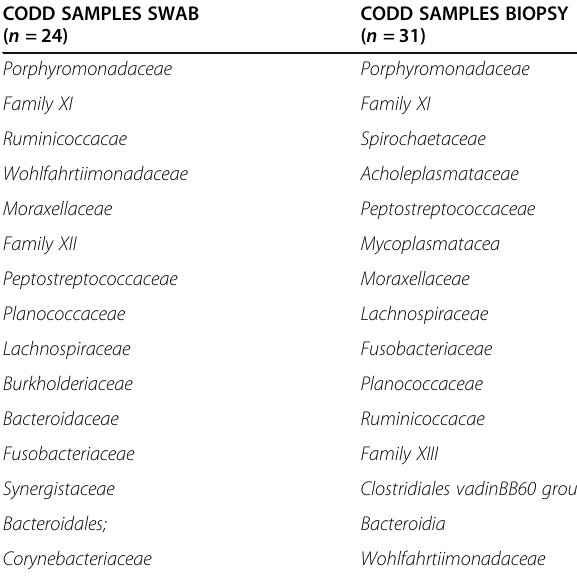
Table 2 Comparison of the 15 most abundant bacterial families present in the microbiome of the ovine foot affected by CODD in samples obtained by bacterial biopsy compared with bacterial